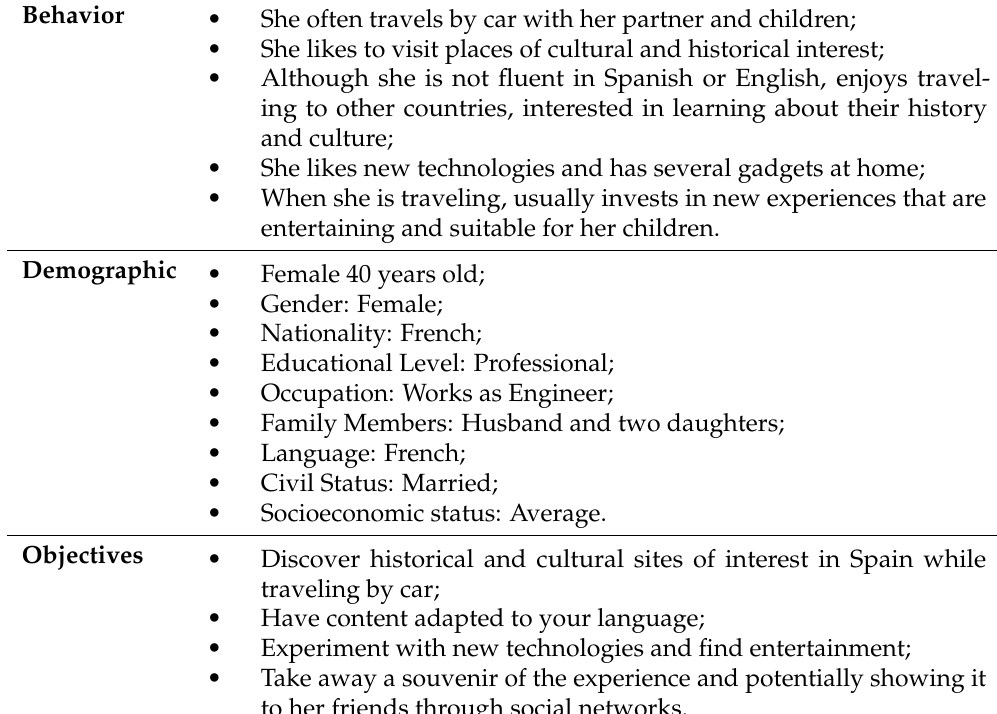
Table 2. Mrs. Dubois definition as